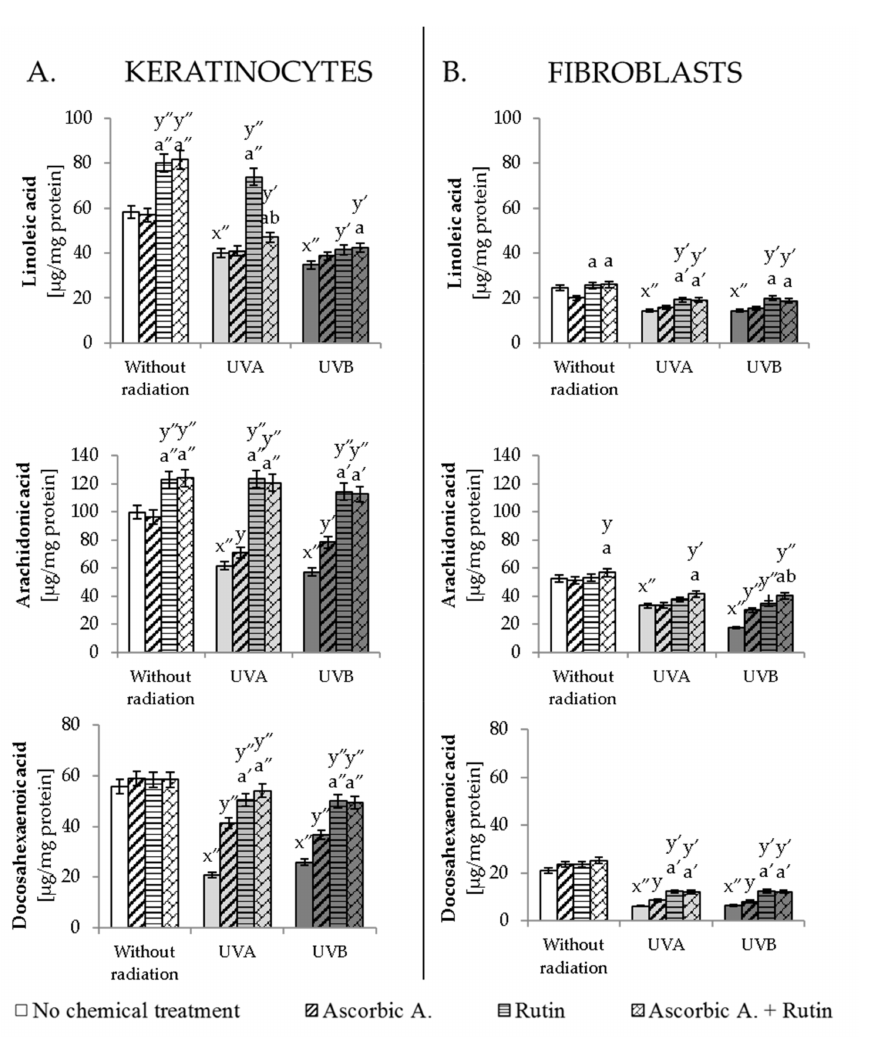
Figure 2. The level of selected phospholipid fatty acids in keratinocytes ( A ) and fibroblasts ( B ) ex- posed to UVA (30 J/cm 2 and 20 J/cm 2 , respectively) and UVB irradiation (60 mJ/cm 2 and 200 mJ/cm 2 , respectively) and treated with rutin (25 µ M) and ascorbic acid (100 µ M). Mean values ± SD of three independent experiments are presented. x significant differences vs. non-treated group, respectively (x (cid:48)(cid:48) for p < 0.0005); y significant differences vs. group without chemical treatment, respectively (y for p < 0.05; y (cid:48) for p < 0.005, y (cid:48)(cid:48) for p < 0.0005); a significant differences vs. ascorbic acid-treated group, respectively (a for p < 0.05; a (cid:48) for p < 0.005, a (cid:48)(cid:48) for p < 0.0005); b significant differences vs. rutin-treated group, respectively (b for p <